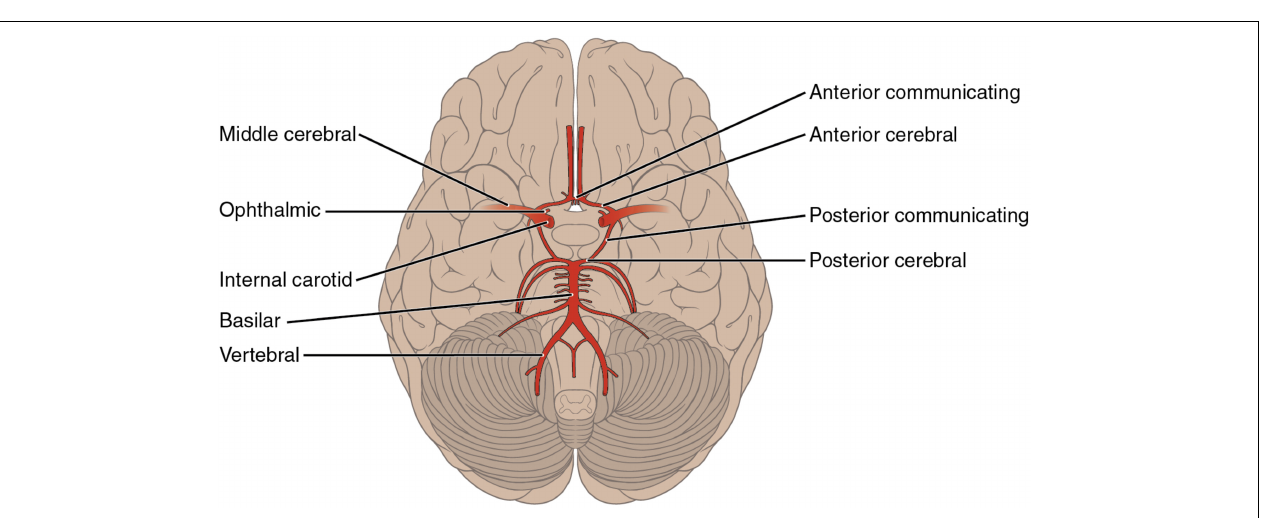
FIGURE 2 | The Anterior Cerebral Artery (ACA) and Anterior Communicating Artery